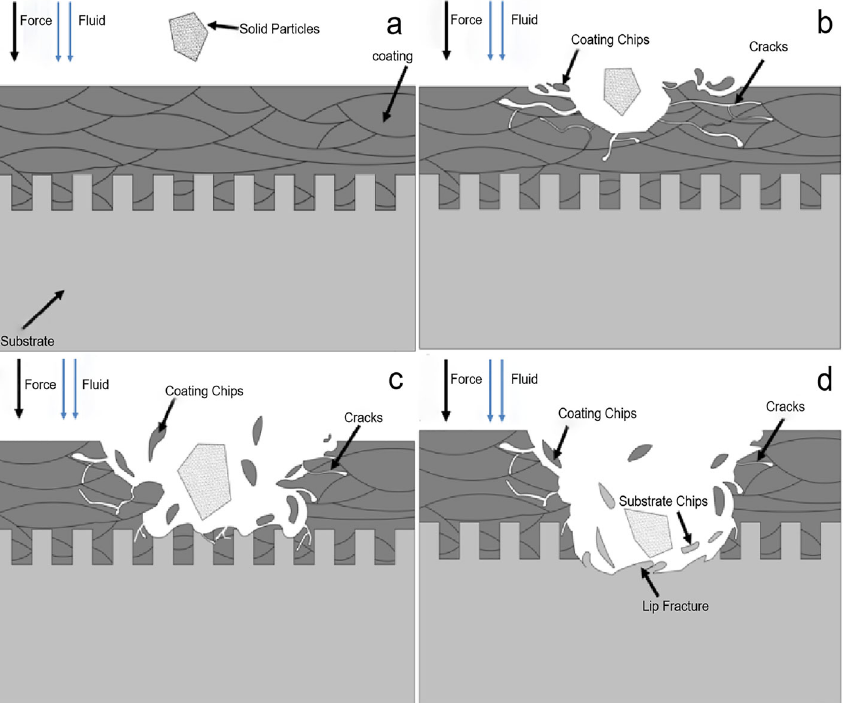
Figure 11. Erosion process of texture in conjunction with WC coating. ( a ) Initial state. ( b ) Coating erosion state. ( c ) Erosion state of coating ‐ substrate bonding interface. ( d ) Substrate erosion state.